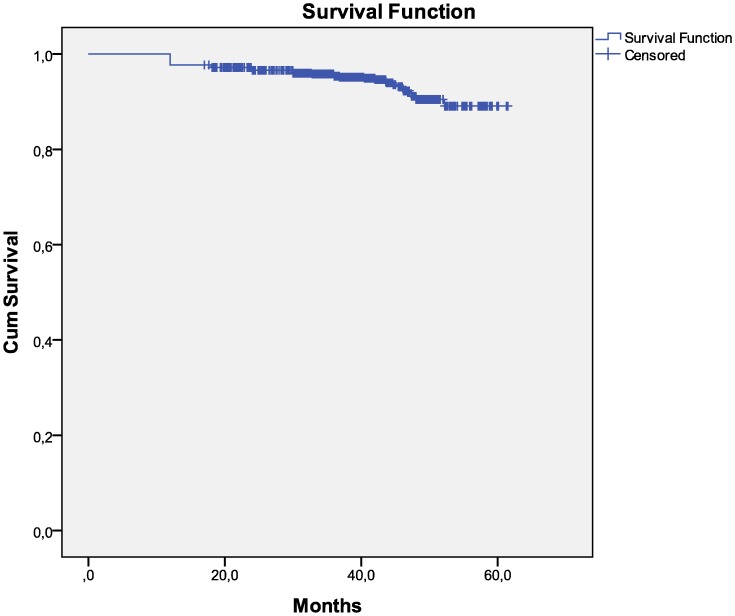
Kaplan Meier analysis from six months of therapy to immunological failure.